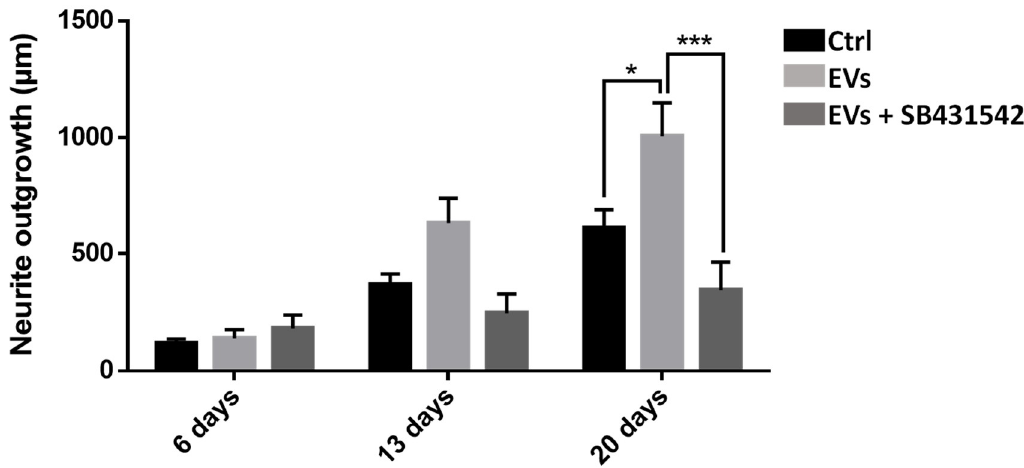
Figure 8. Influence of nGDF-dependent EVs in neurite outgrowth assays. Leech neurons were primarily cultured with either EV-enriched fraction, EV-enriched fraction + TGF- β signaling pathway inhibitor (SB431542) or control supernatants from enrichment procedure. After measures of neurite length, the EV-activated condition showed a significant higher outgrowth at day 20 compared to the control. The presence of SB431542 inhibitor in cells submitted to EV-activated condition showed a significant lower outgrowth at day 20 compared to EV-enriched fraction alone. Significance (* p < 0.05, *** p < 0.001) was calculated by ANOVA paired t -test (bar represents standard errors of mean).